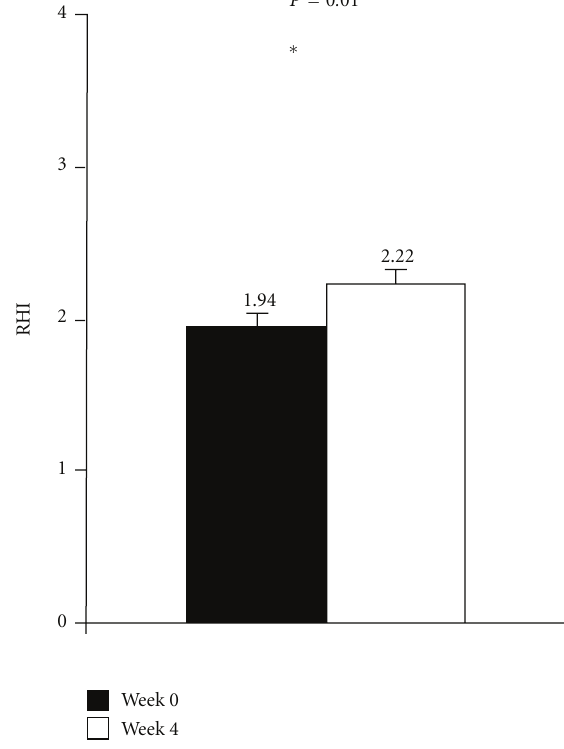
Figure 3: Mean reactive hyperemia index (RHI) evaluated by Endo- PAT2000 at baseline (week 0) and at the end of the study (week 4) ( n =